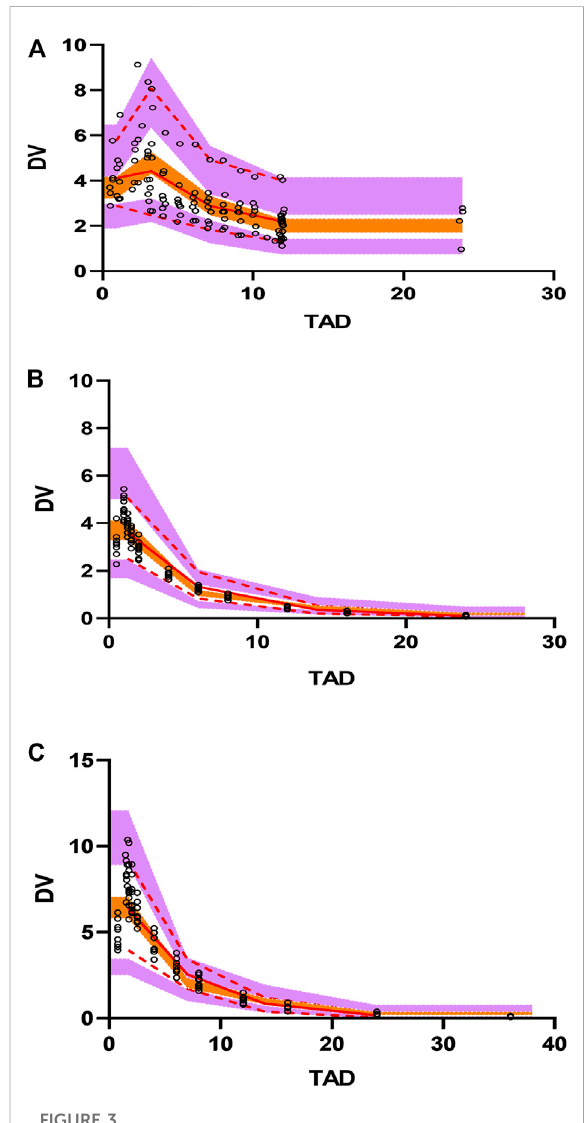
Visual predictive check (VPC) plots for the polymyxin B concentration in plasma. (A) VPC for BSI patients. (B) VPC for healthy subjects with .75 mg/kg dosing administration. (C) VPC for healthy subjects with 1.5 mg/kg dosing administration. Open circles represent observed concentrations. The solid red line represents the median of the observations. The red dashed lines represent the 5th and 95th percentiles of the observations. The purpleshadedareasrepresentthe95%con fi denceintervalsforthe 5th and 95th percentiles, and the orange shaded areas represents the median of the predicted